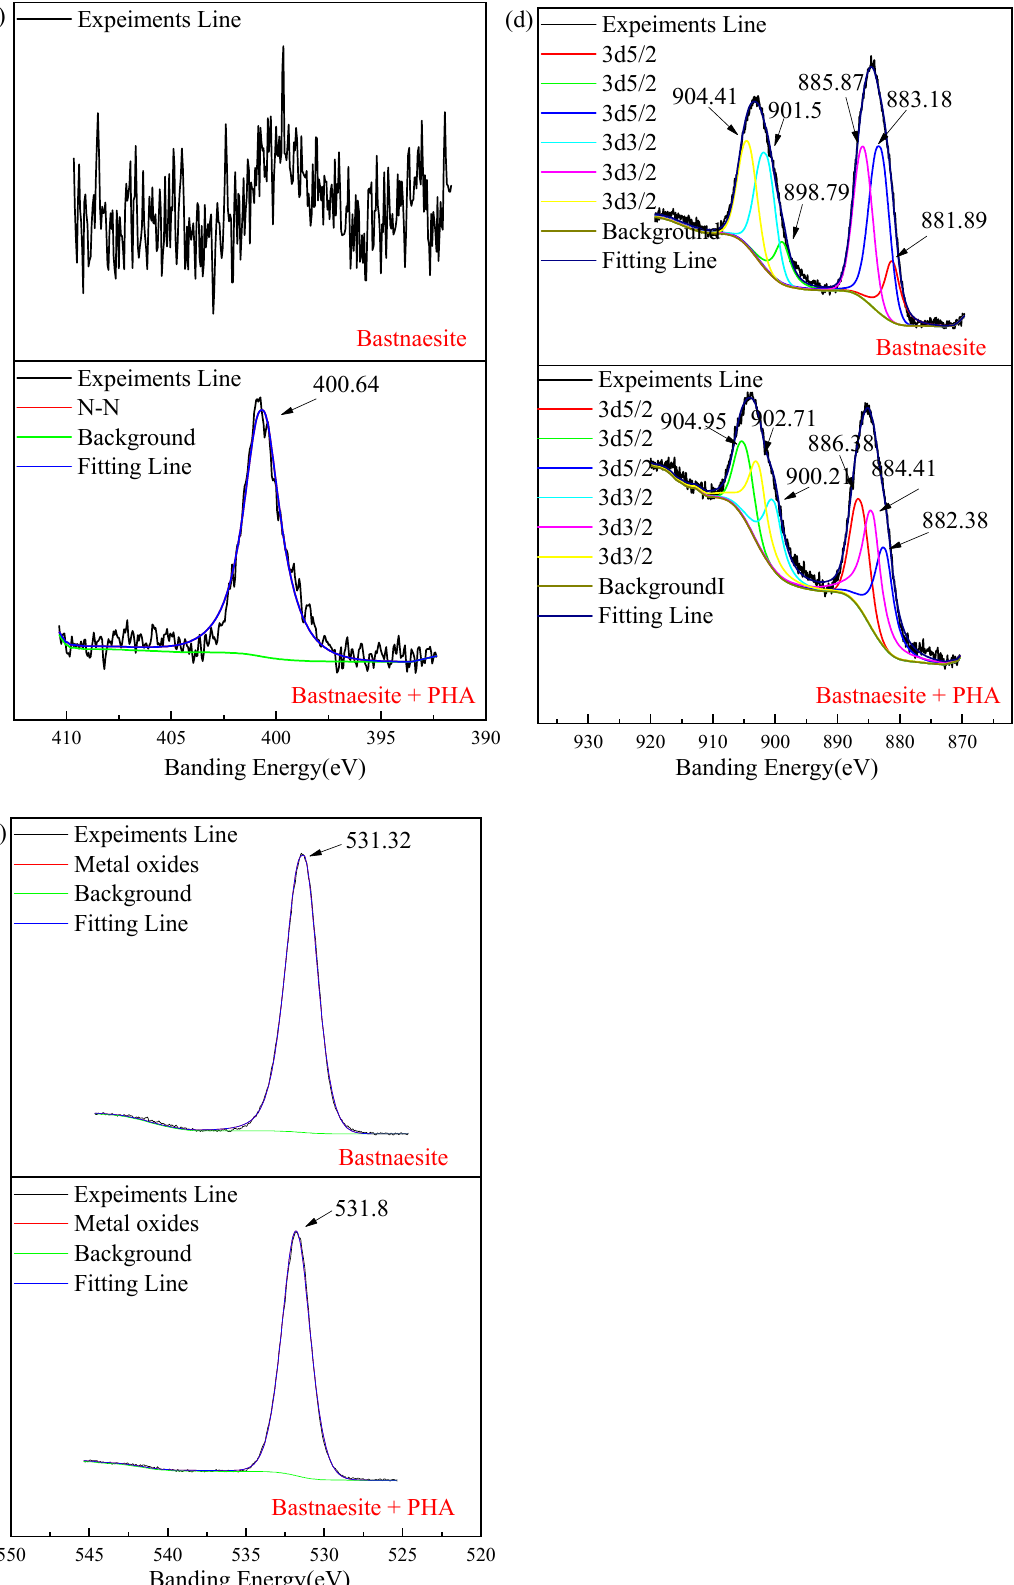
Figure 8. XPS analysis spectrum of wolframite before and after treating with PHA. (( a ) survey, ( b ) C 1s, ( c ) N 1s, ( d ) Ce, ( e )